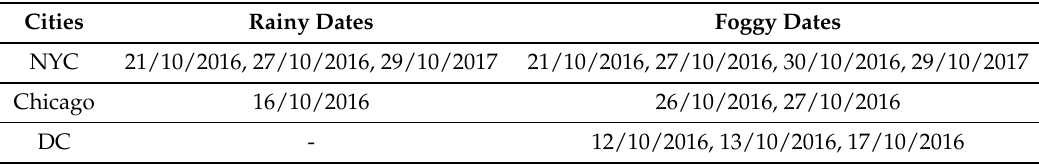
Table 2. The rainy dates and foggy dates in New York City, Chicago, and Washington